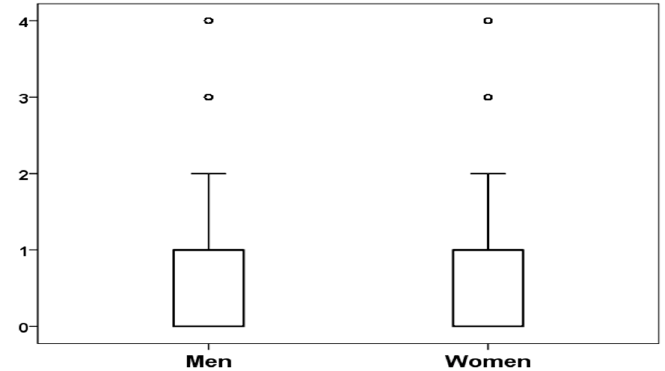
Figure 1. Boxplot of number of work-related events and changes experienced in the previous 12 months by men and women.